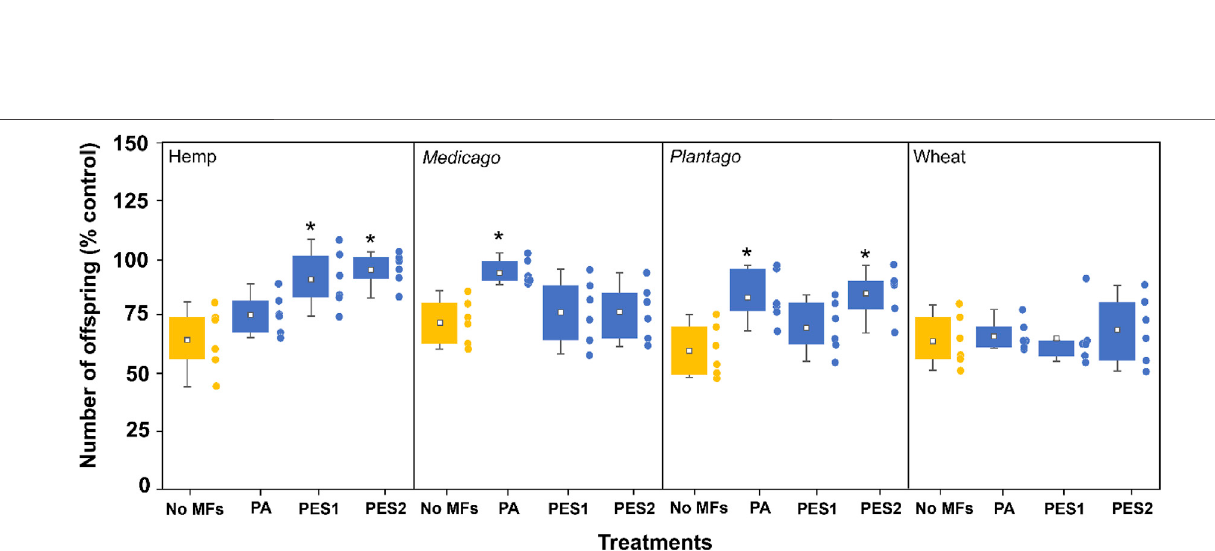
Frontiers in Environmental Science |